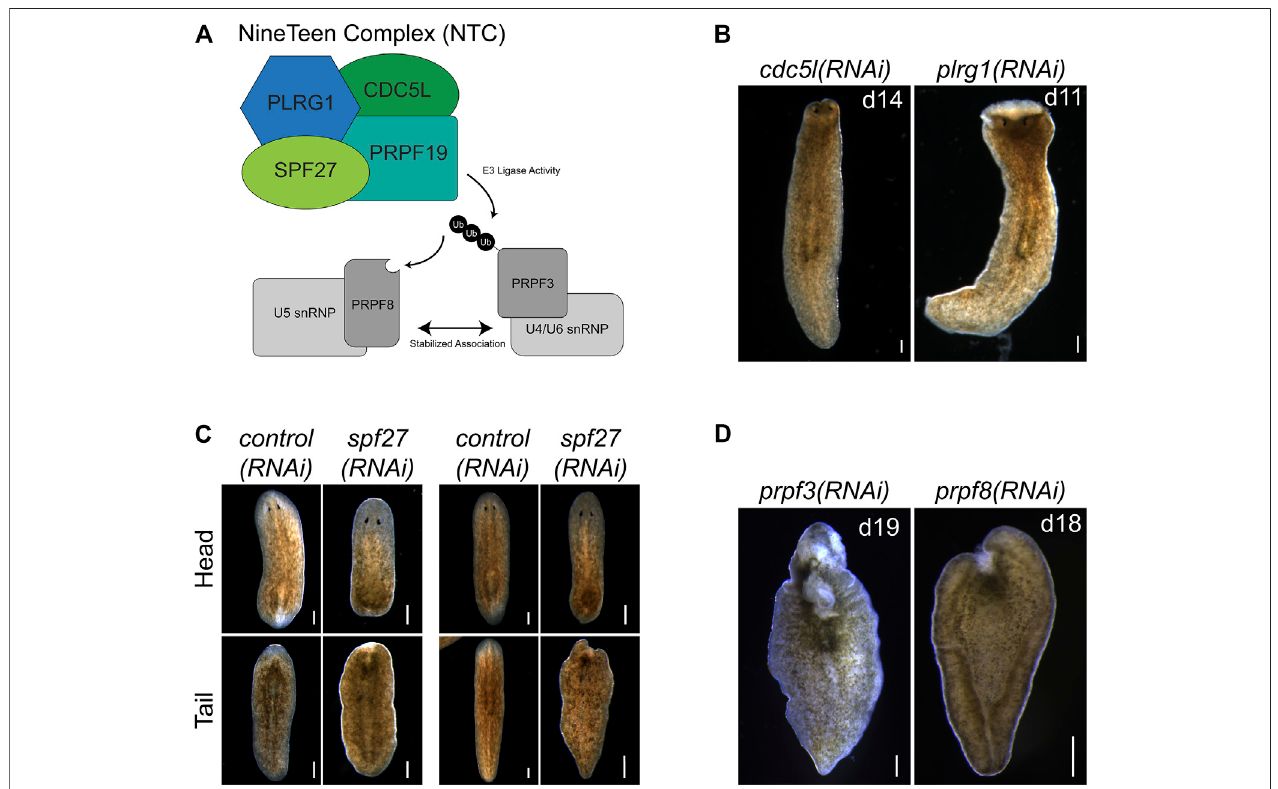
FIGURE4| prpf19 -associatedfactorsanddownstreamtargetsrecapitulate prpf19(RNAi) phenotypes. (A) Prpf19actsasanE3ligaseinNTC,interactingwithcore complexmembersPLRG1,CDC5l,andSPF27tomodifyU4/U6snRNPsubunitPRPF3withnonproteolyticK63-linkedubiquitinchains.Thisubiquitylmarkstabilizesthe interaction of PRPF3 with U5 snRNP subunit PRPF8 to allow the stable formation of the U4/U6.U5 tri-snRNP and the catalytic activity of the spliceosome. (B) Knockdown of indicated NTC core components cdc5l and plrg1 displaying head regression (N (cid:1) 19/41 and 24/44 respectively) and lysis (N (cid:1) 39/41 and 20/44, respectively). (C) Knockdown of NTC core component spf27 caused a reduced and delayed regenerative response in amputated worms. At 6 days post-amputation, spf27(RNAi) worms have smaller blastemas compared to control(RNAi) worms at the same time point. At day 11 post-amputation, the regenerative response in control(RNAi) worms is largely concluded with large blastemas and visible reformed eyespots present in trunk fragments. In comparison, spf27(RNAi) worms have smaller blastemas (N (cid:1) 28/37 for head fragments), and tail fragments have not regenerated normal eyespots (N (cid:1) 33/37). (D) Inhibition of Prpf19 target prpf3